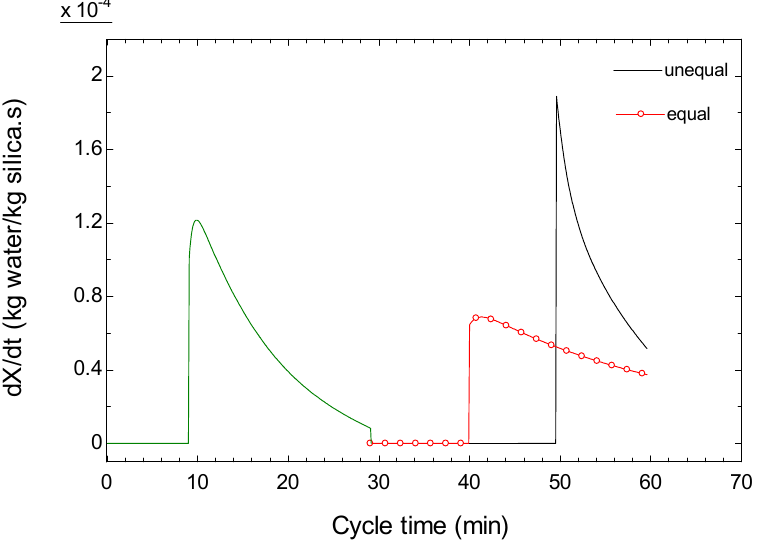
Figure 3. Adsorption velocity rate variation.